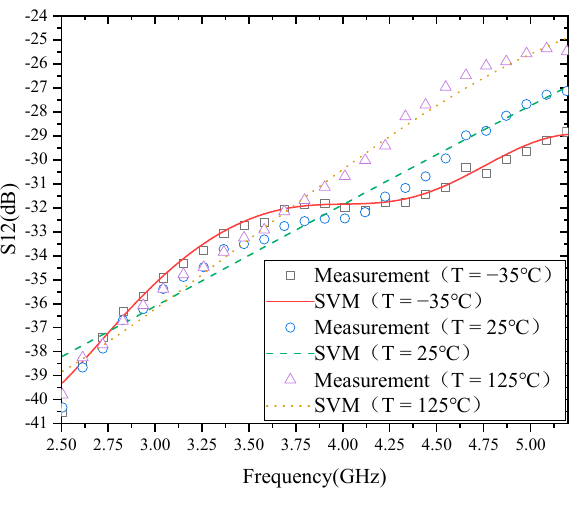
Figure 5. Modeling results of S12.